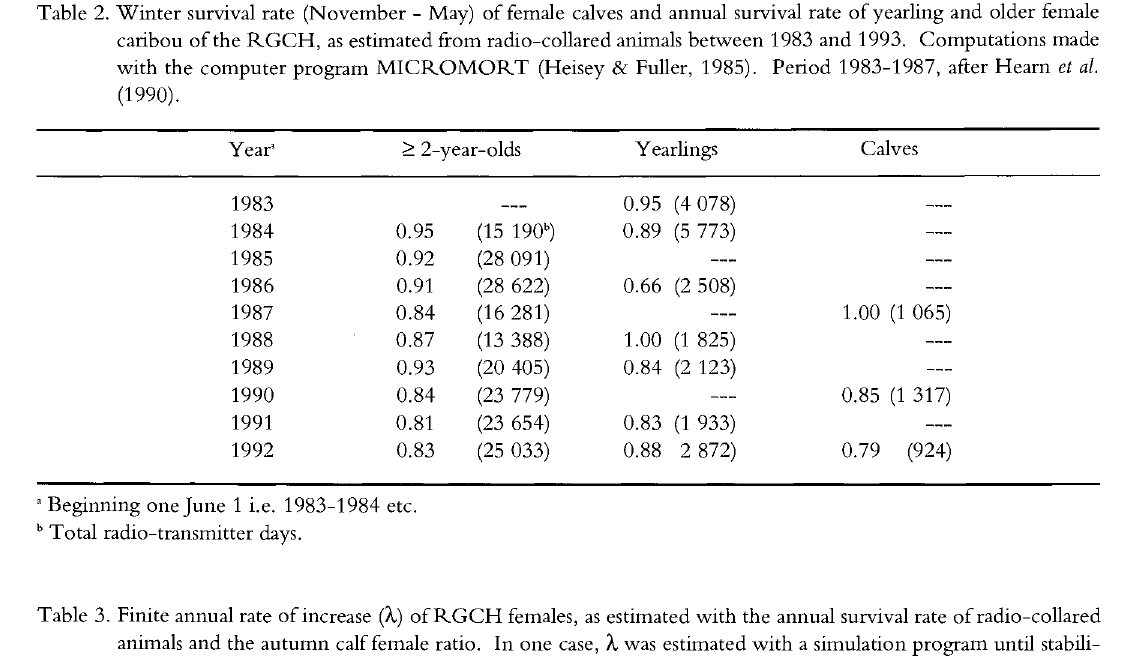
Table 3. Finite annual rate of increase (X) of R G CH females, as estimated with the annual survival rate of radio-collared animals and the autumn calffemale ratio. In one case, X was estimated with a simulation program until stabili zation of the age structure; in the other, the 1984-1992 period was simulated with time in continue.